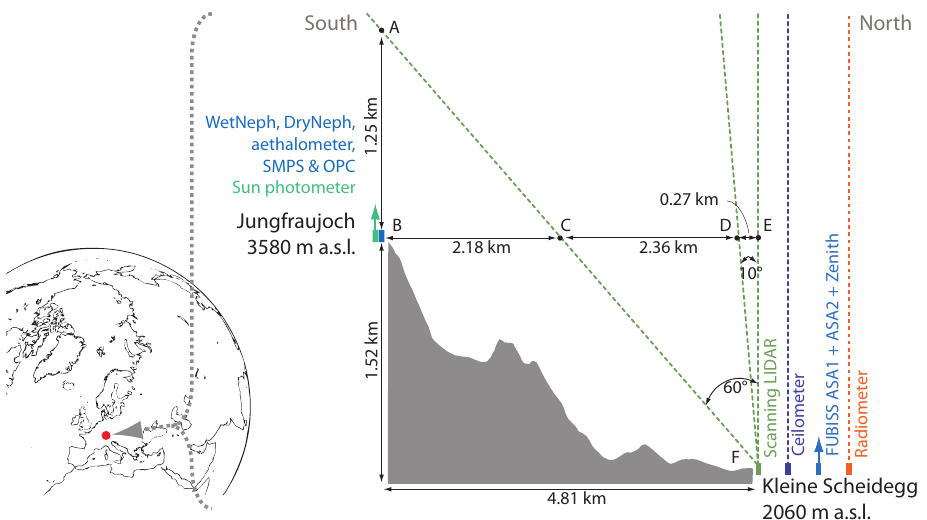
Fig. 1. Set-up and measurement geometry during the CLACE 2010 campaign performed at the Jungfraujoch and the Kleine Scheidegg, Switzerland (red bullet on left